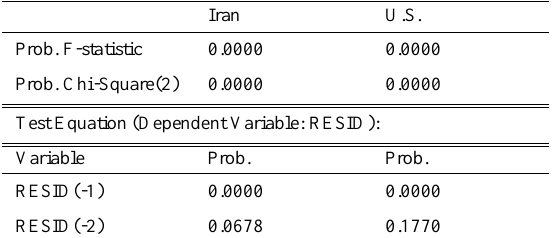
Table 6: Serial correlation test of weekly returns Breusch-Godfrey Serial Correlation LM Test: